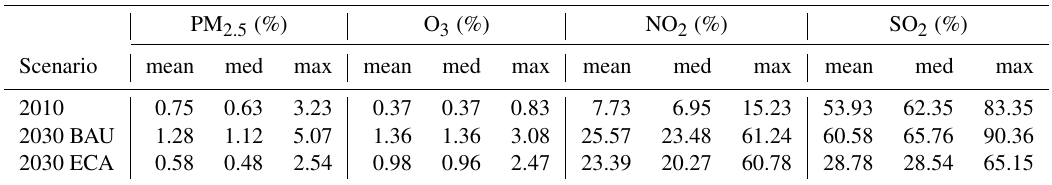
Table 7. Arctic shipping contributions to population-weighted concentrations of criteria pollutants over eastern Canadian Arctic (north of 60 ◦ N, 60–100 ◦ W), for the July–August–September